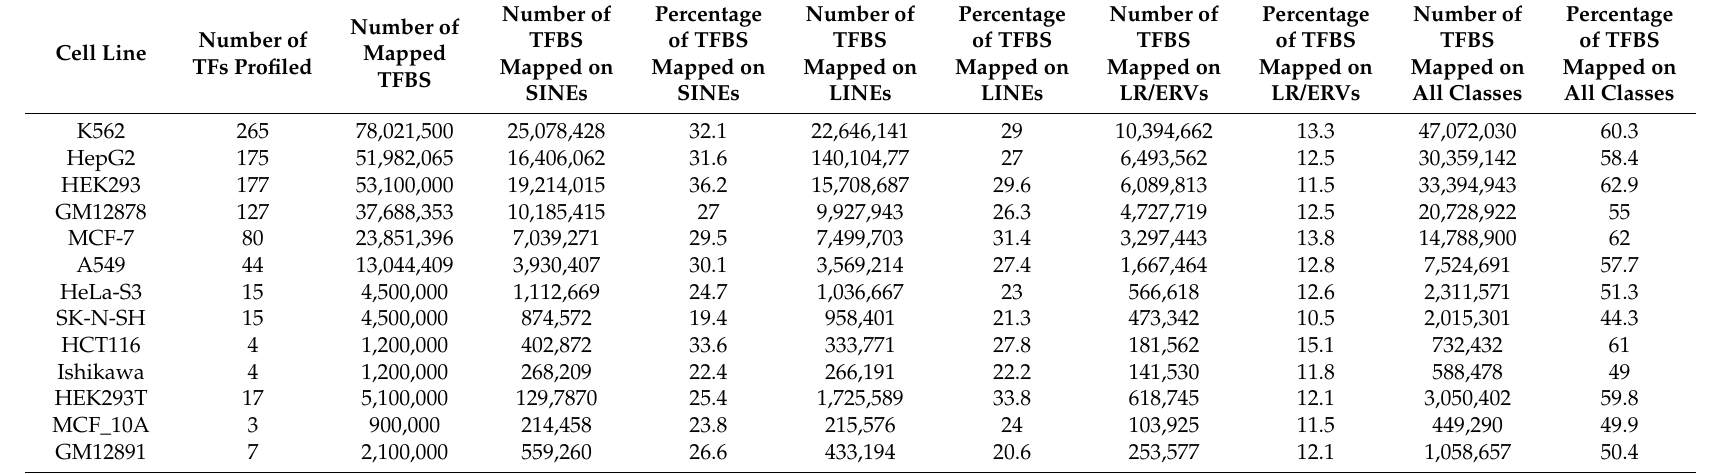
Table 1. Overall transcription factor binding sites (TFBS)